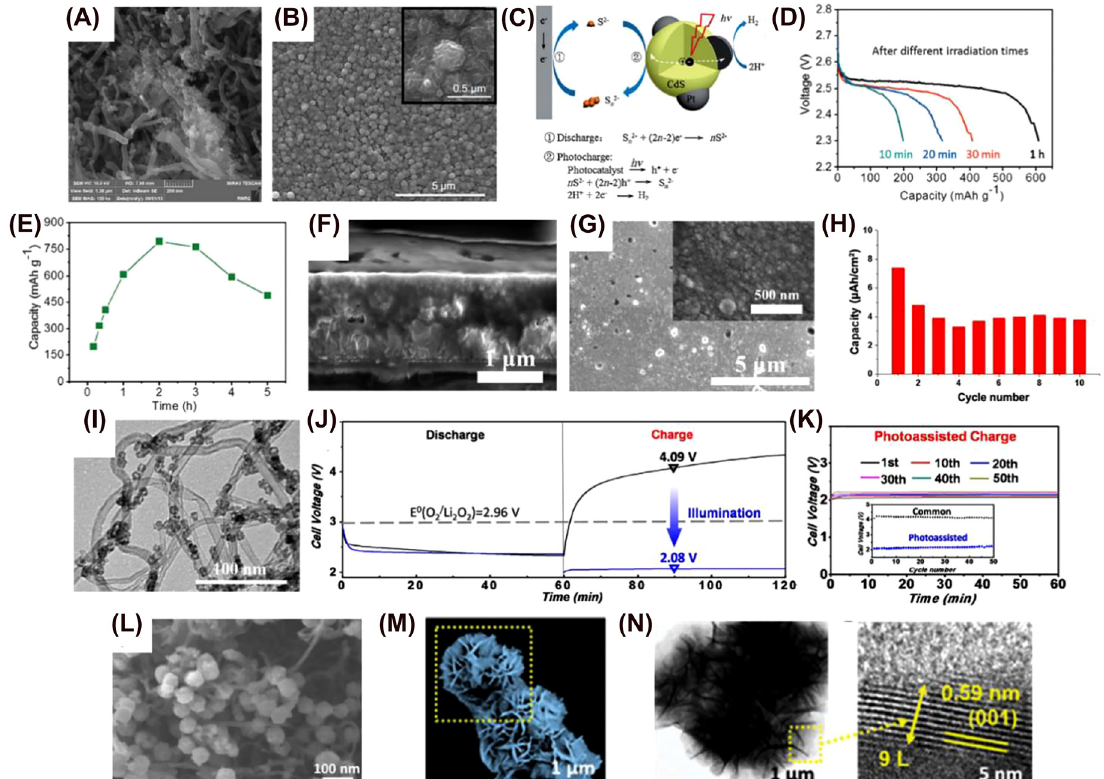
Figure 8: Structure and performance of chalcogenide-based